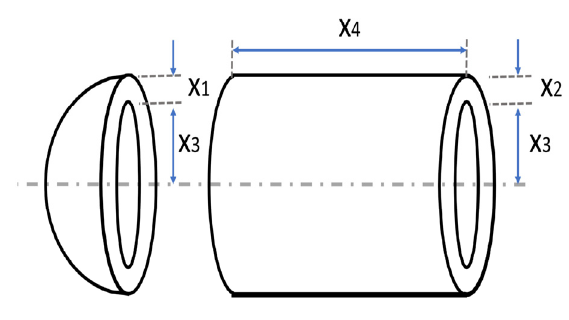
Figure 2. Pressure vessel design problem